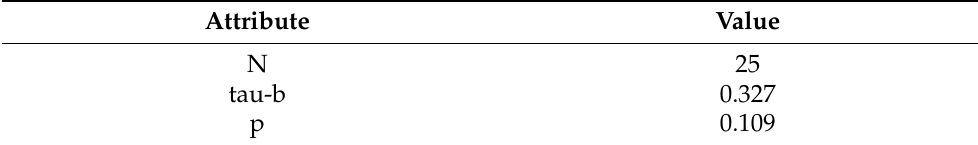
Table 4. Kendall’s tau-b result for lambsquarters classification